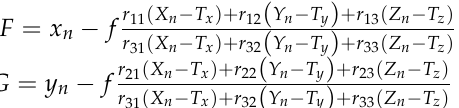
Figure 6. Multiple image filtering concept diagram.